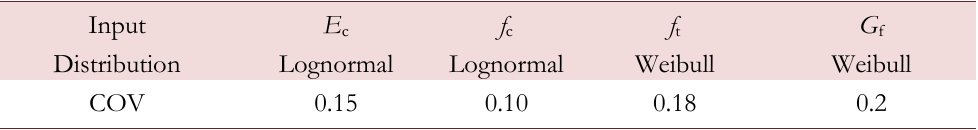
Table 6: Material properties in the stochastic modelling - concrete.